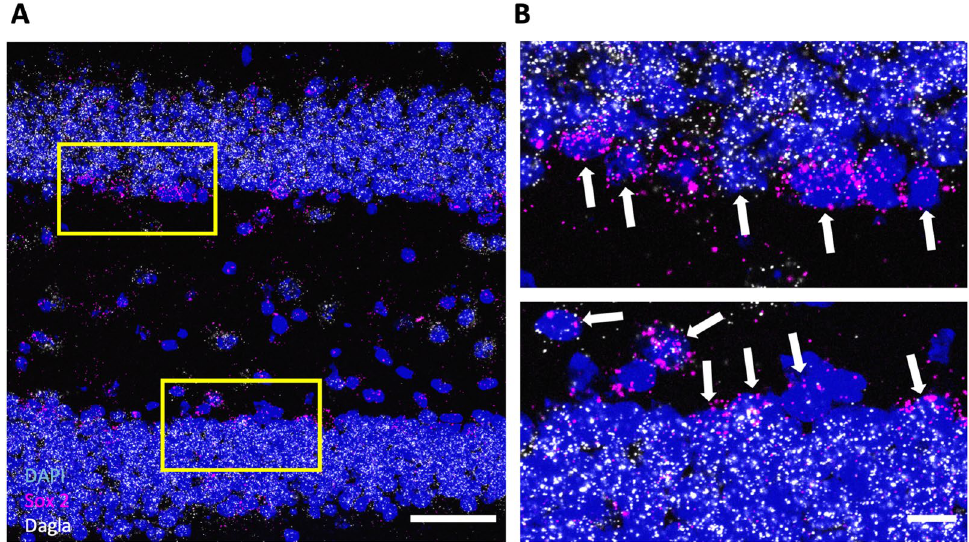
Figure 1. Dagla is expressed in neural stem and progenitor cells (NSPCs). ( A ) Representative image of an RNAscope in situ hybridisation assay detecting transcripts of diacylglycerol lipase alpha Dagla (white) and neural progenitor marker Sox 2 (magenta) in the dentate gyrus of hippocampus (DG) (scale bar 50 µm). ( B ) The magnified insets (scale bar 10 µm) show the subgranular zone (SGZ); the progenitor layer in the DG. White arrows indicate Sox 2 -positive cells that co-express Dagla (scale bar 10